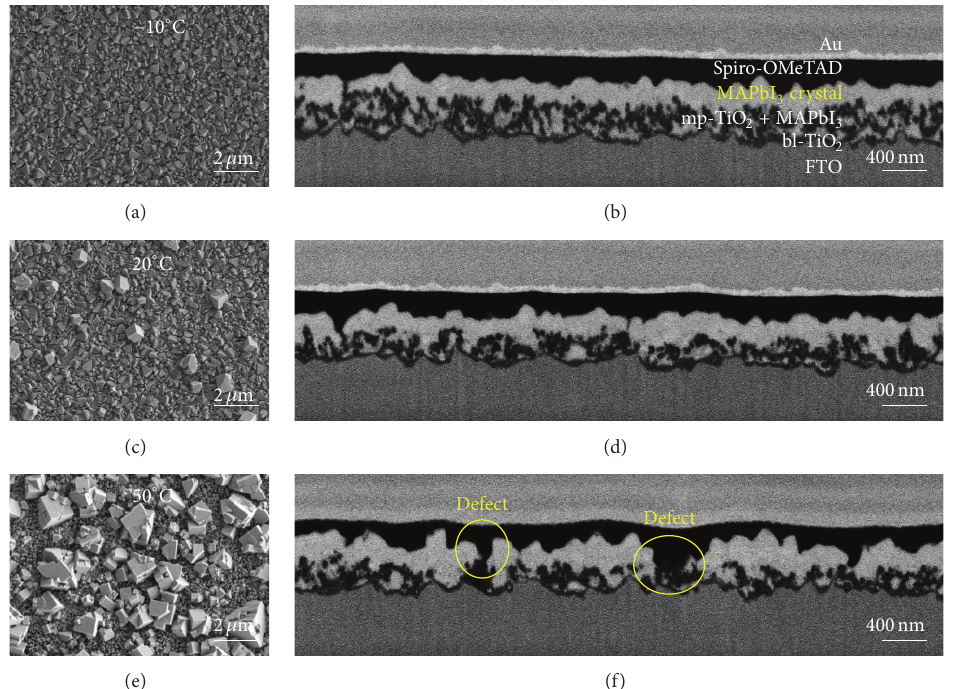
Figure 11: (a) Top-down SEM for − 10 ∘ C. (b) Cross-sectional SEM for − 10 ∘ C. (c) Top-down SEM for 20 ∘ C. (d) Cross-sectional SEM for 20 ∘ C. (e) Top-down SEM for 50 ∘ C. (f) Cross-sectional SEM for 50 ∘ C. Reproduced from [24] with permission from the Royal Society of Chemistry.